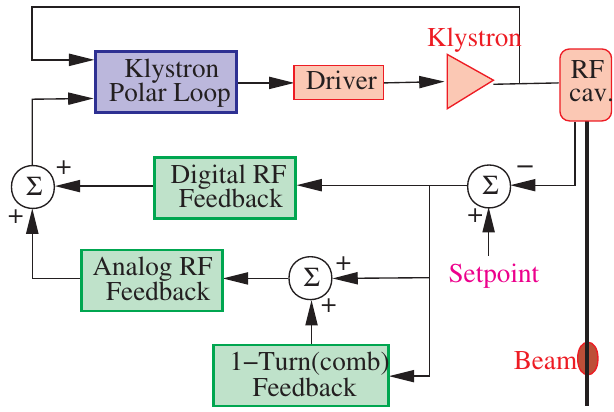
diagram.*themis@slac.stanford.edu †